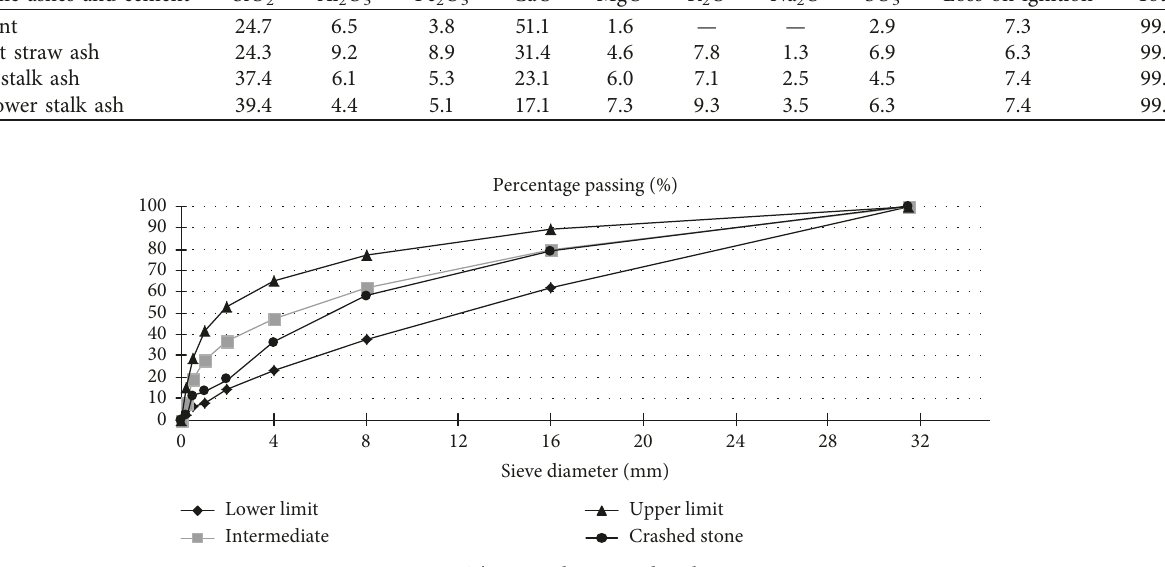
Figure 1: The granulometric distribution. Table 2: Physical properties of the cement.